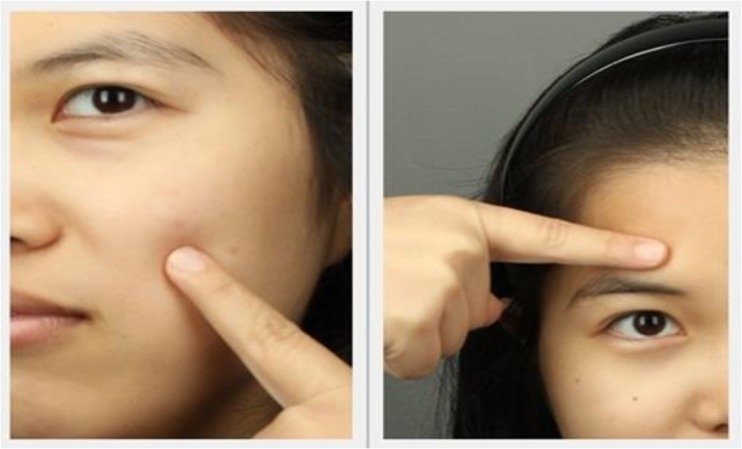
Skin color measurement of face regions.Locations of skin color measurements. Measurements were made from the left cheek, right cheek and forehead using a Konica Minolta CM2600d spectrophotometer. Measurements were made in the CIELab color space, in duplicate. Mean values across both measurements and all 3 locations were calculated for luminance (L*), redness (a*) and yellowness (b*) color axes. The individual in the image has given written informed consent (as outlined in the PLoS consent form) to publish her image.